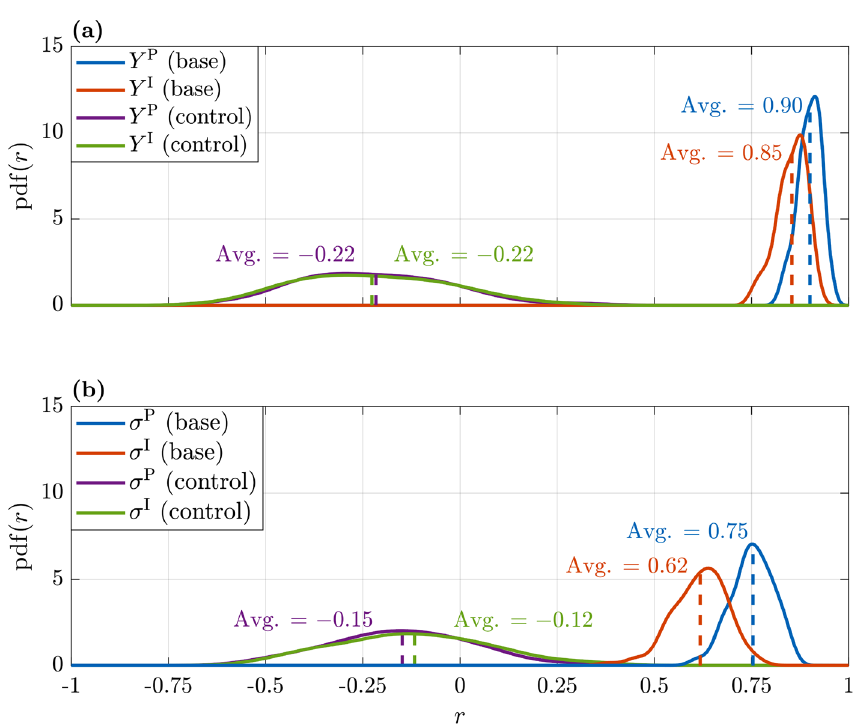
Figure 8. Probability density functions over 100 experiments. Subplot (a): correlations of model simulations and Y P and Y I datasets ( r ( X V , Y P ) in blue and r ( X V , Y I ) in red). The probability density functions obtained with the control experiments are reported in purple and in green. In this case, e g = 0.43 ∀ g and c g = 0.13 ∀ g . Subplot (b): correlations model simulations and the standard deviation of σ P and σ I datasets x (blue and red for the base experiment, purple and green for the control one). Dashed vertical lines are centered on the average